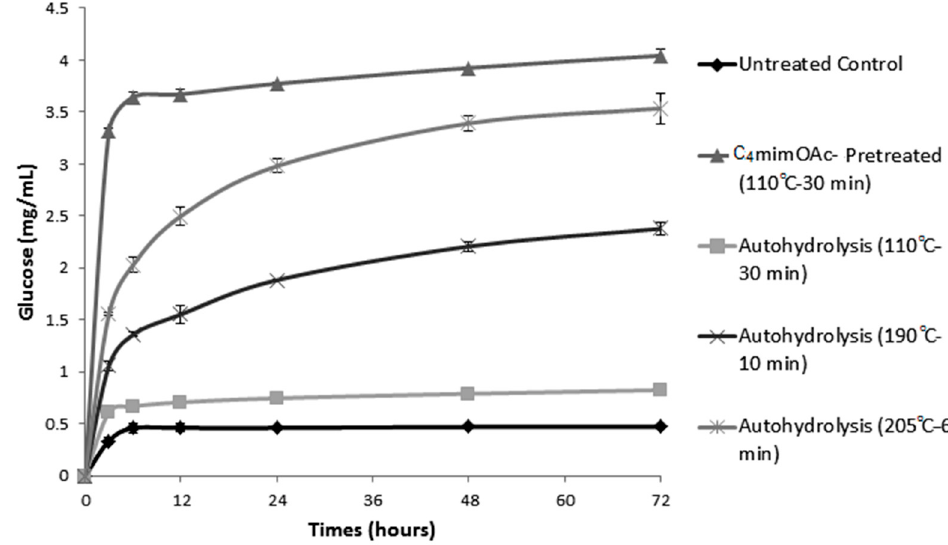
Figure 1. Glucose concentration (mg/mL) obtained after enzymatic hydrolysis of autohydrolysis and 1-n-butyl-3-methylimidazolium acetate (C 4 mimOAc)-pretreated bagasse.